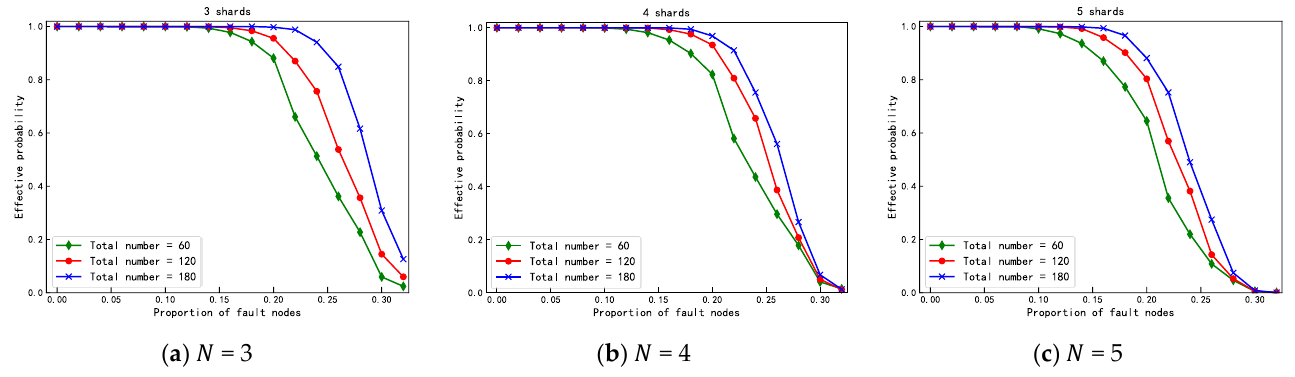
Figure 11. Overall effectiveness analysis of the total number of nodes in the system. These three figures respectively describe the probability that the entire system is effective when the number of shards is the same and the total number of nodes is different. Among which (a) The number of shard is 3; (b) The number of shard is 4; (c) The number of shard is 5.